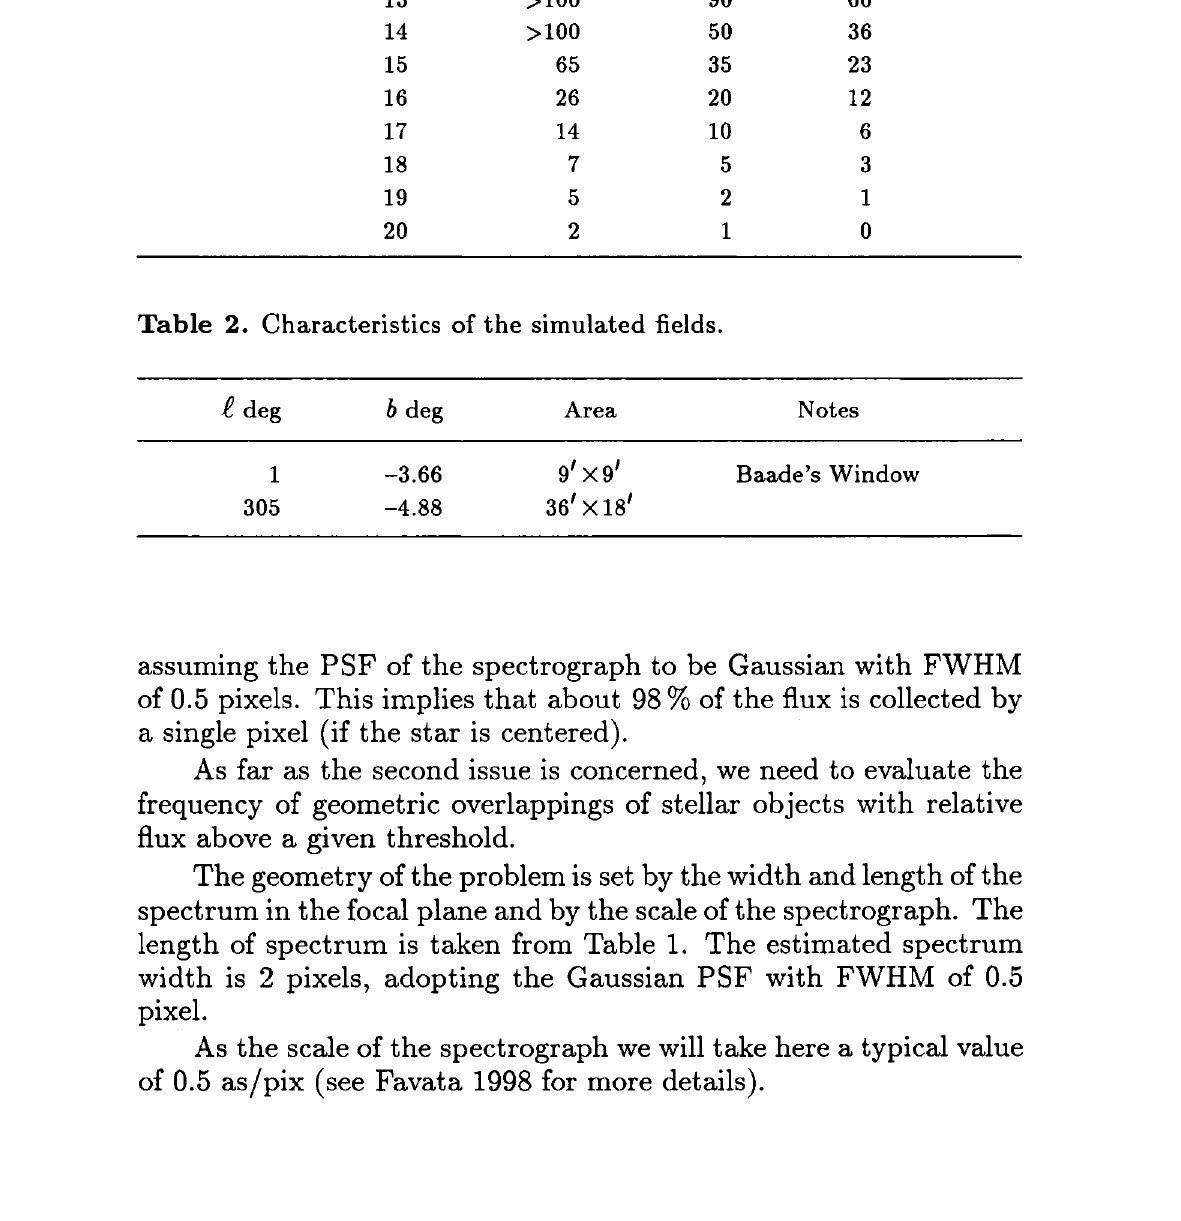
Table 1. Signal to noise ratio as a function of V magnitude and resolution (Favata 1998). Â/pix 100 50 25 SI. length (pix)